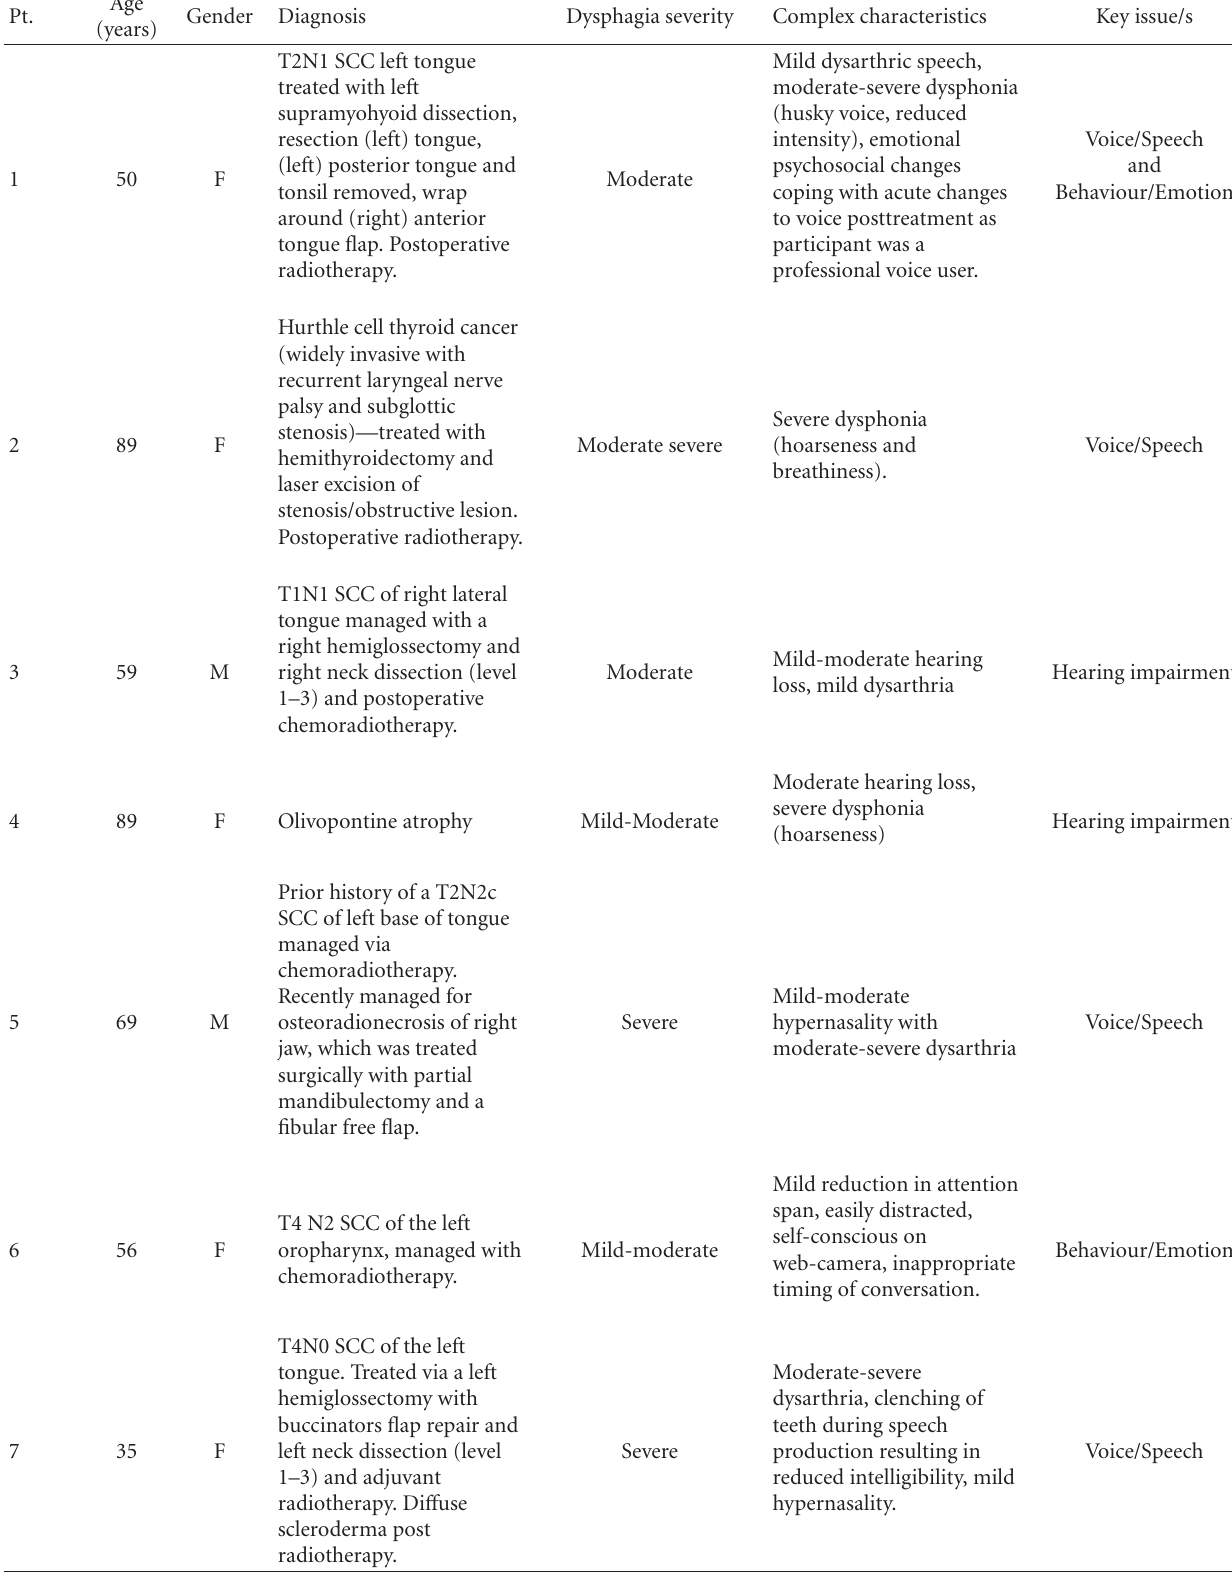
Table 1: Description of presenting characteristics of the 10 participants and the key issues complicating the assessment session.